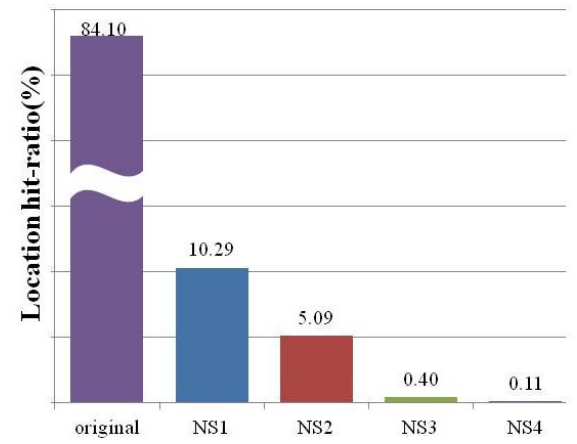
Figure 11. A verage location hit-ratio using